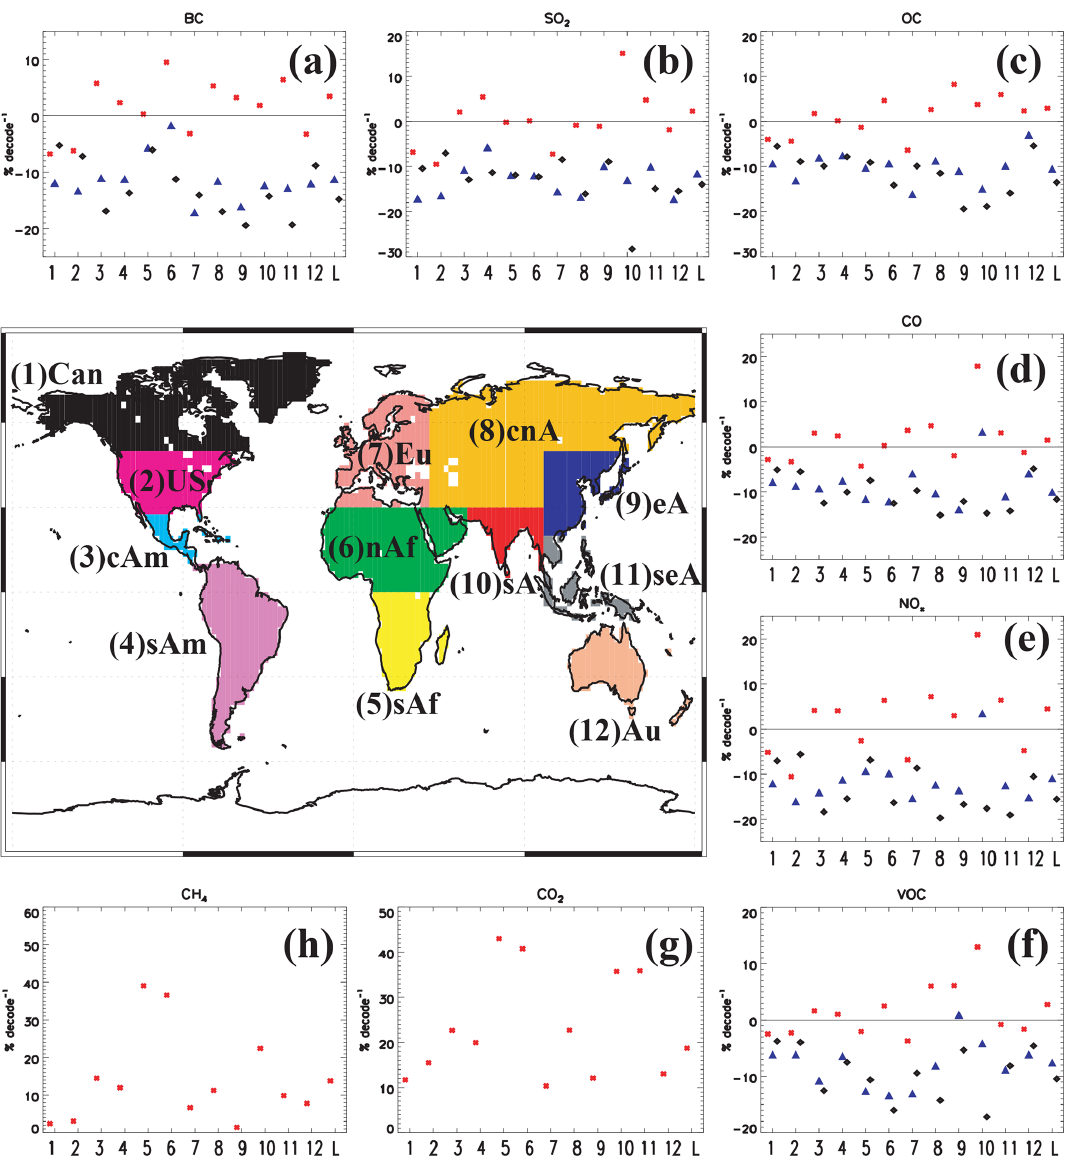
Figure 2. The 2015–2055 regional mean CO 2 , NTCF, and precursor gas emission trends. Regional 2015–2055 emission trends for (a) black carbon (BC); (b) sulfur dioxide (SO 2 ); (c) organic carbon (OC); (d) carbon monoxide (CO); (e) nitrogen oxides (NO x ); (f) volatile organic compounds (VOCs); (g) carbon dioxide (CO 2 ); and (h) methane (CH 4 ) for weak (red asterisks) and strong air quality control (SSP3-7.0- lowNTCF; blue triangles) and NTCF mitigation (SSP3-7.0-lowNTCF − SSP3-7.0; black diamonds). The center map shows the corresponding color-coded world regions, based on Seneviratne et al. (2012). The following abbreviations are used: Canada: 1 (Can; black), United States: 2 (US; magenta), Central America: 3 (cAm; sky blue), South America: 4 (sAm; purple), south Africa: 5 (sAf; yellow), north Africa: 6 (nAf; green), Europe: 7 (Eu; pink), central and north Asia: 8 (cnA; orange), east Asia: 9 (eA; navy), south Asia: 10 (sA; red), southeast Asia: 11 (seA; gray), and Australia: 12 (Au; beige). The average over these 12 land regions is abbreviated as “L”. Trend units are %decade − 1 (relative to 2015). Only weak air quality control CO 2 and CH 4 emission trends are shown, as AerChemMIP simulations include the same change in CO 2 and CH 4 emissions based on the weak air quality control scenario. Emissions data come directly from the CMIP6 forcing datasets, which were downloaded from